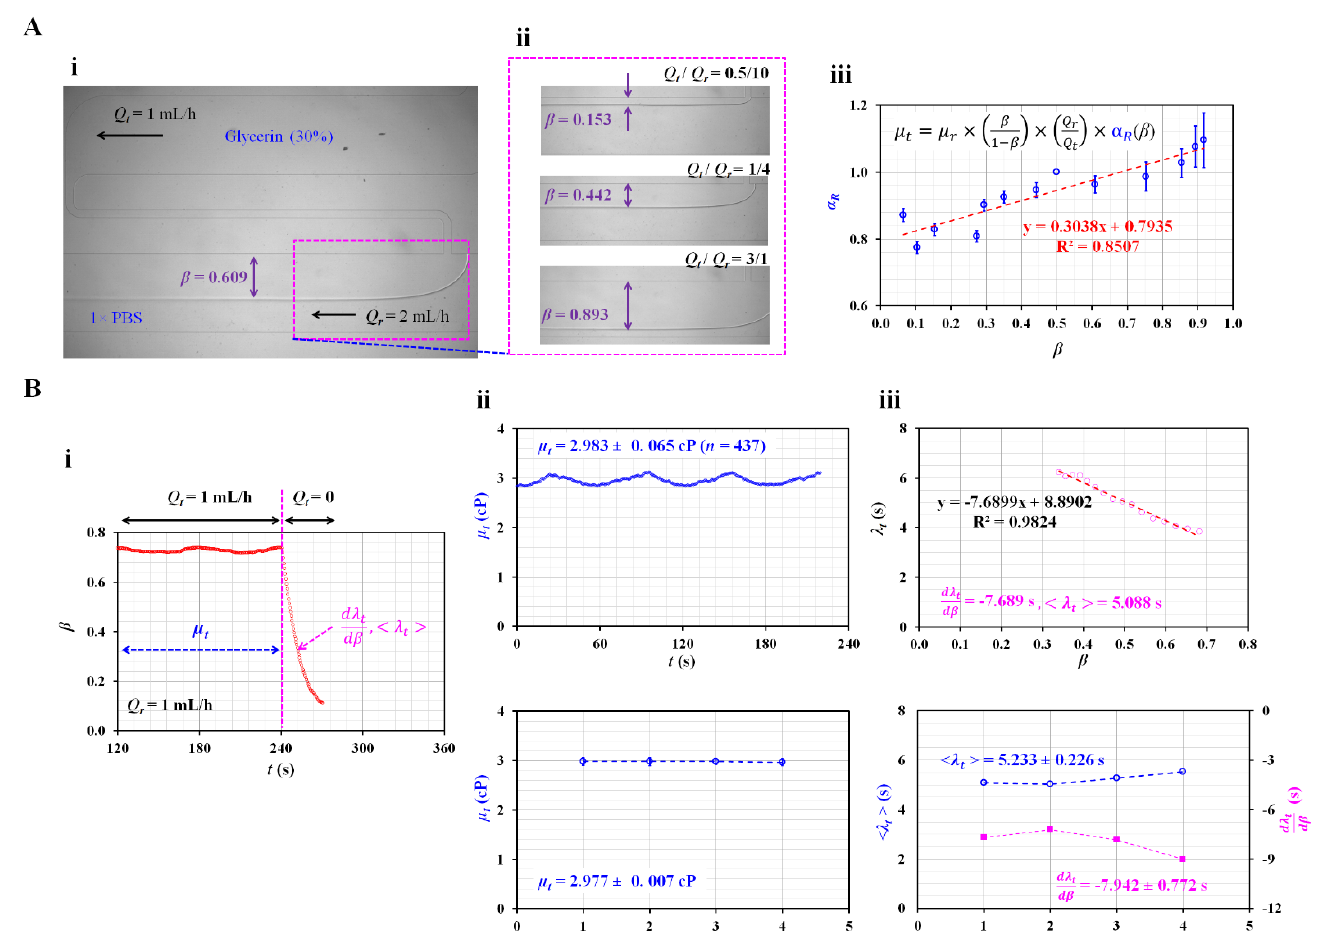
Figure 2. Quantification of the correction factor ( α R ) in the governing equation and determination of viscosity and time constant of glycerin (30%) as the test fluid. ( A ) Quantification of the correction factor ( α R ) as a linear expression of the interface in the coflowing channel. ( i ) Microscopic image of the interface in the coflowing channel. The arrow (‘ ← ’) denoted flow direction of glycerin (30%) and 1× PBS. ( ii ) Variations in β with respect to flow rate ratio ( Q t / Q r ). ( iii ) Variations in correction factor ( α R ) with respect to β . ( B ) Measurement of viscosity ( µ t ) and time constant ( λ t ) under square-wave flow rate of the test fluid. ( i ) Viscosity and time constant were obtained at steady and transient flows, respectively. Linear slope ( dλ t / dβ ) and averaged time constant (< λ t >) were selected to quantify the dynamic variation in the test fluid. ( ii ) Temporal variations in µ t and variations of µ t over four periods ( n = 4). The viscosity of glycerin (30%) was obtained as µ t = 2.977 ± 0.007 cP. ( iii ) Variations in λ t with respect to β , and variations in d λ t / d β and < λ t > over four periods ( n = 4). During four consecutive periods ( n = 4), dλ t / dβ and < λ t > were obtained as – 7.942 ± 0.772 s and 5.233 ± 0.226 s, respectively.